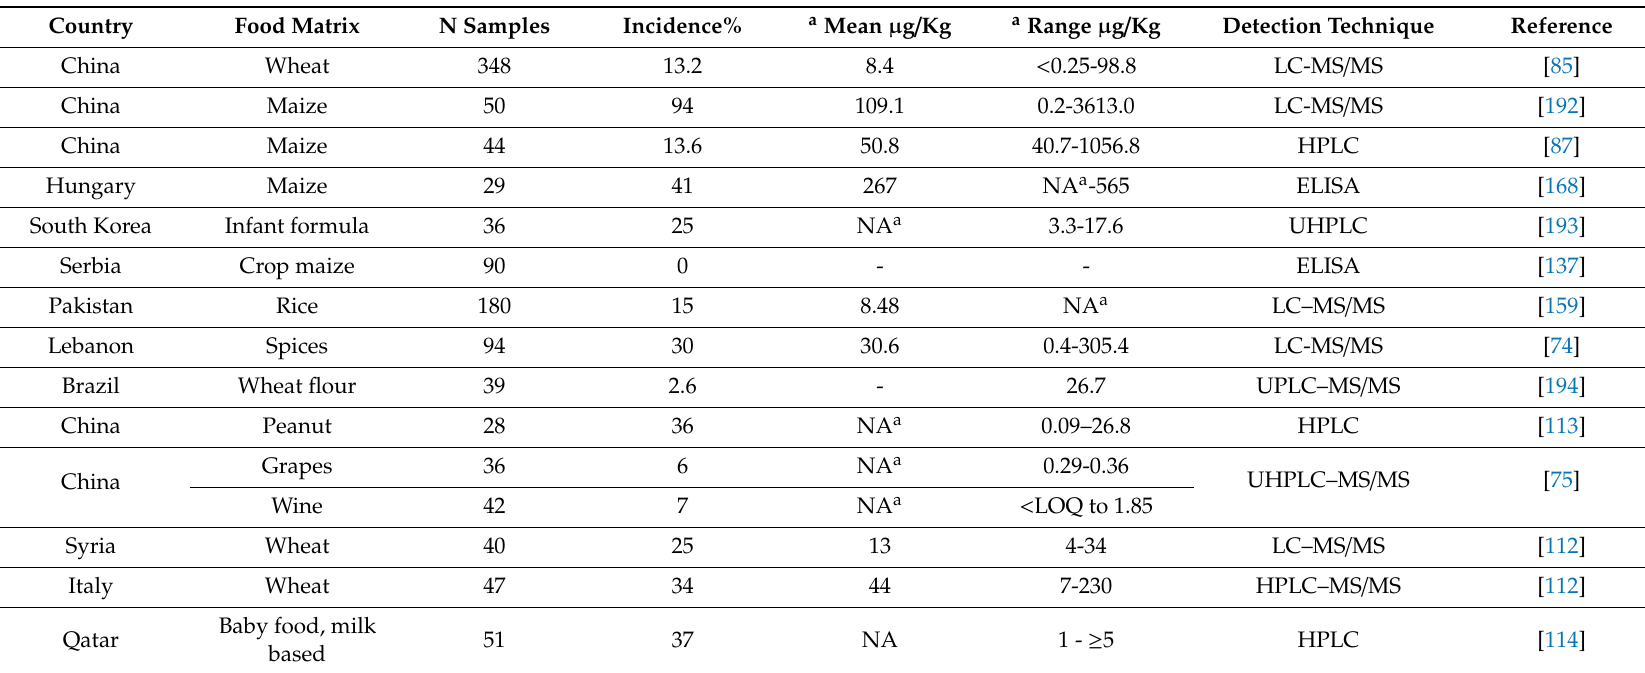
Table 8. Representative studies on the occurrence of ZEN distribution ( µ g / kg) in food samples around the world during 2014–2019.